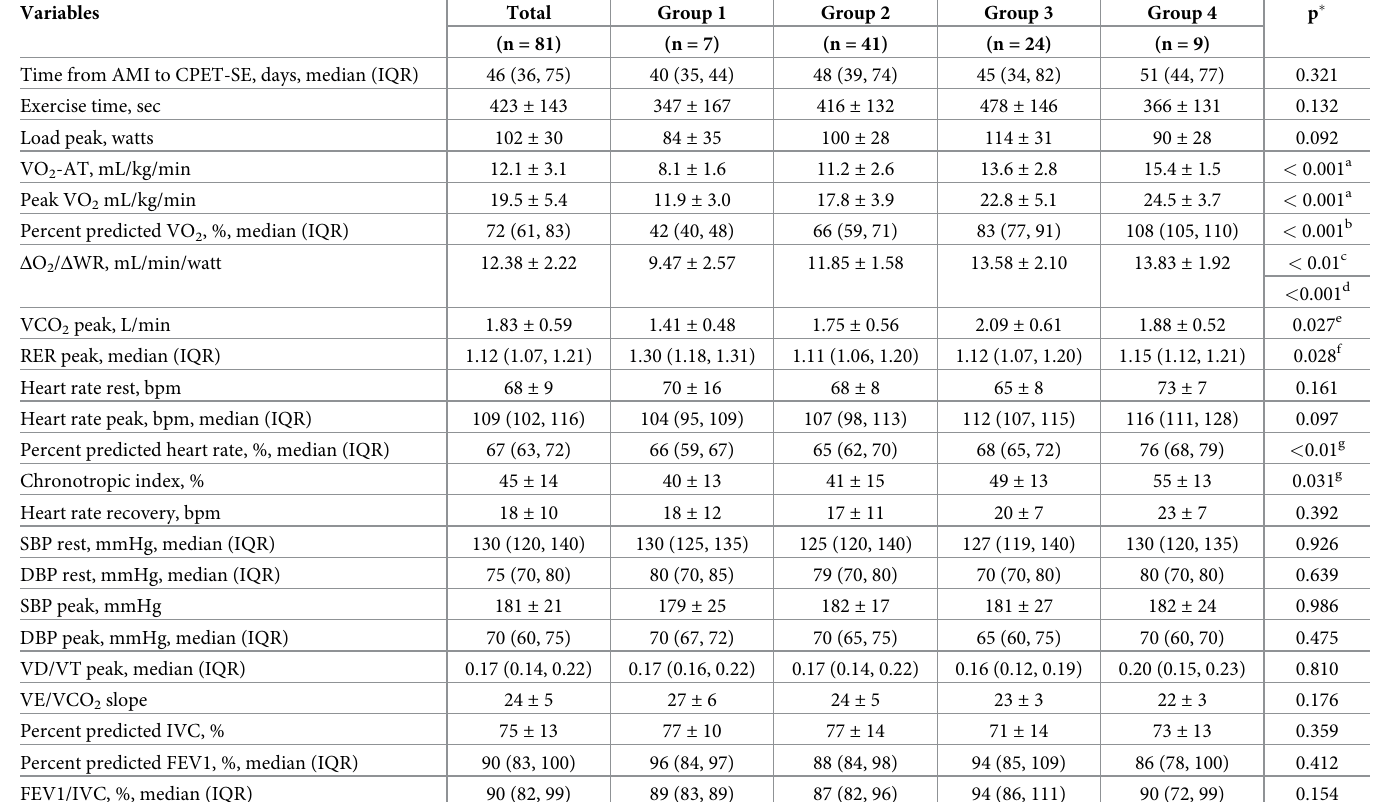
Table 2. Cardiopulmonary parameters during combined exercise testing according to percentage of predicted oxygen uptake (Group 1, < 50%; Group 2, 50–74%; Group 3, 75–99%; and Group 4, � 100%). Variables Total